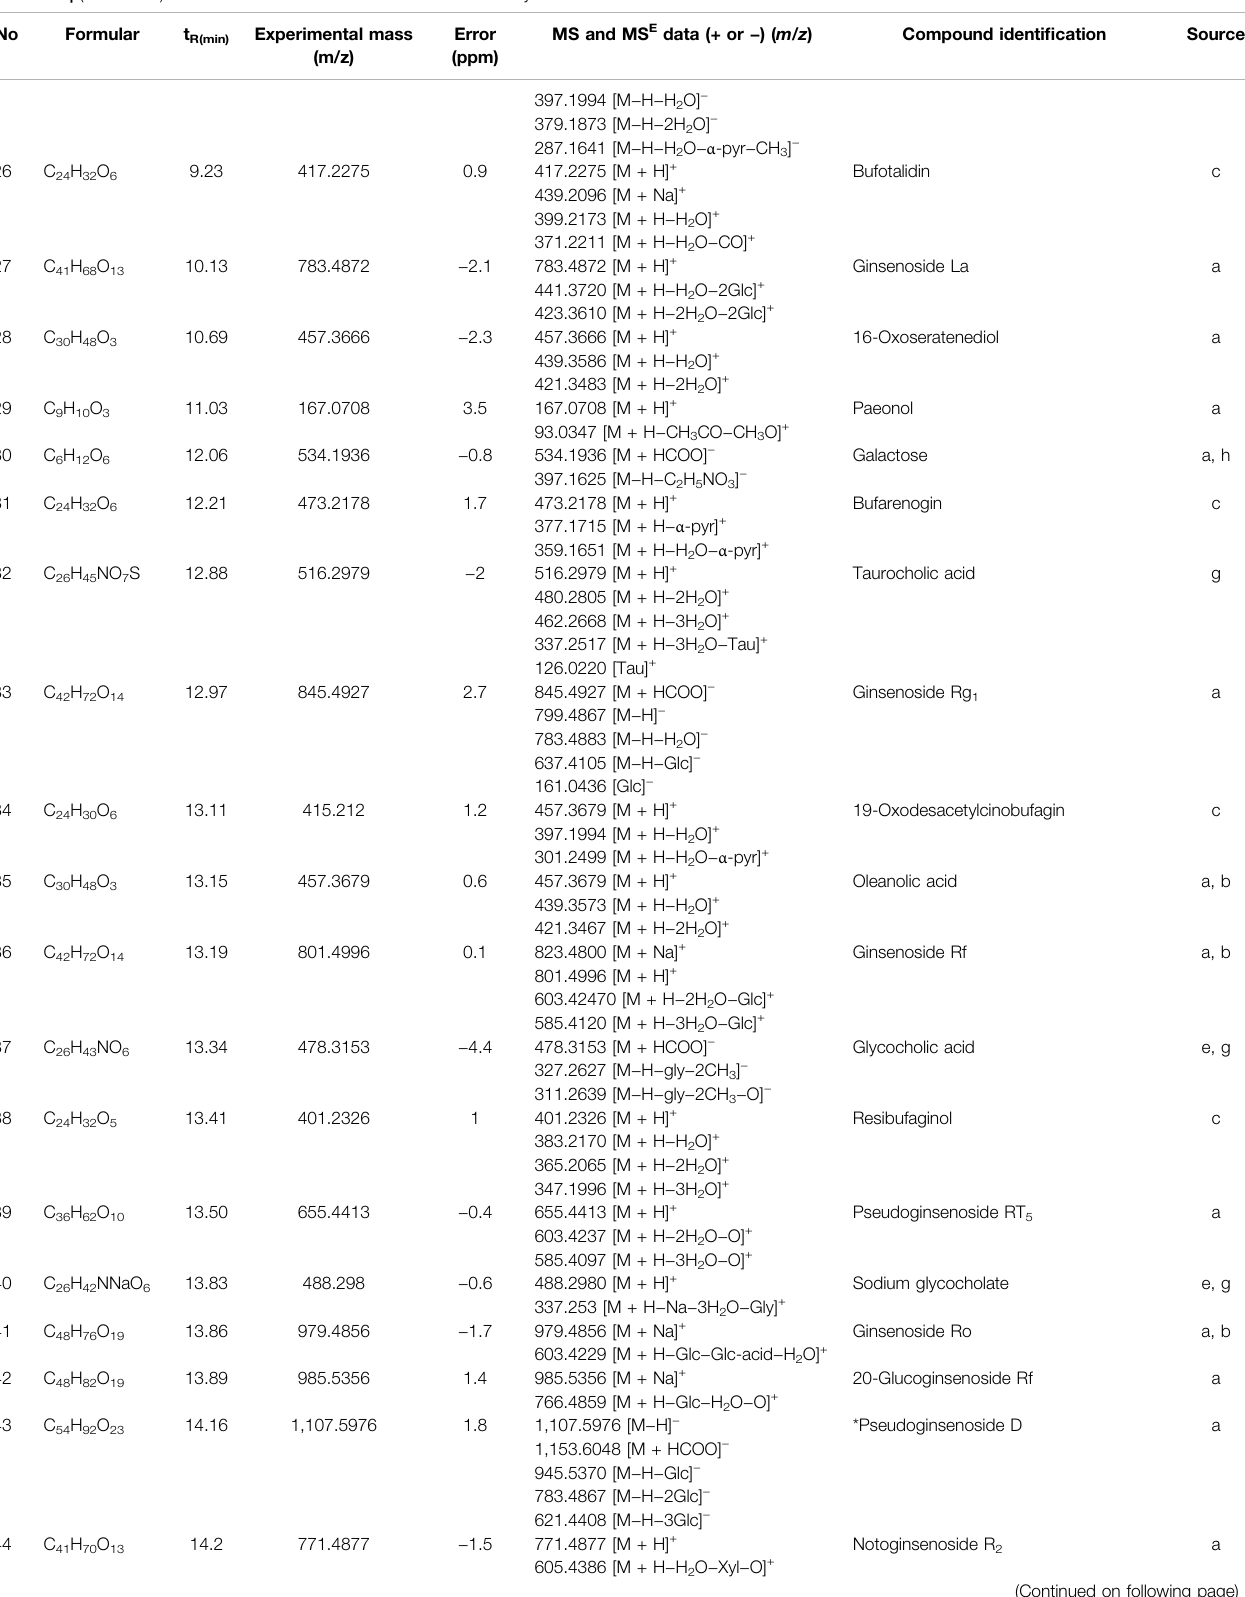
TABLE 1 | ( Continued ) Identi fi cation of chemical constituents of HJP by UPLC/Q − TOF − MS E